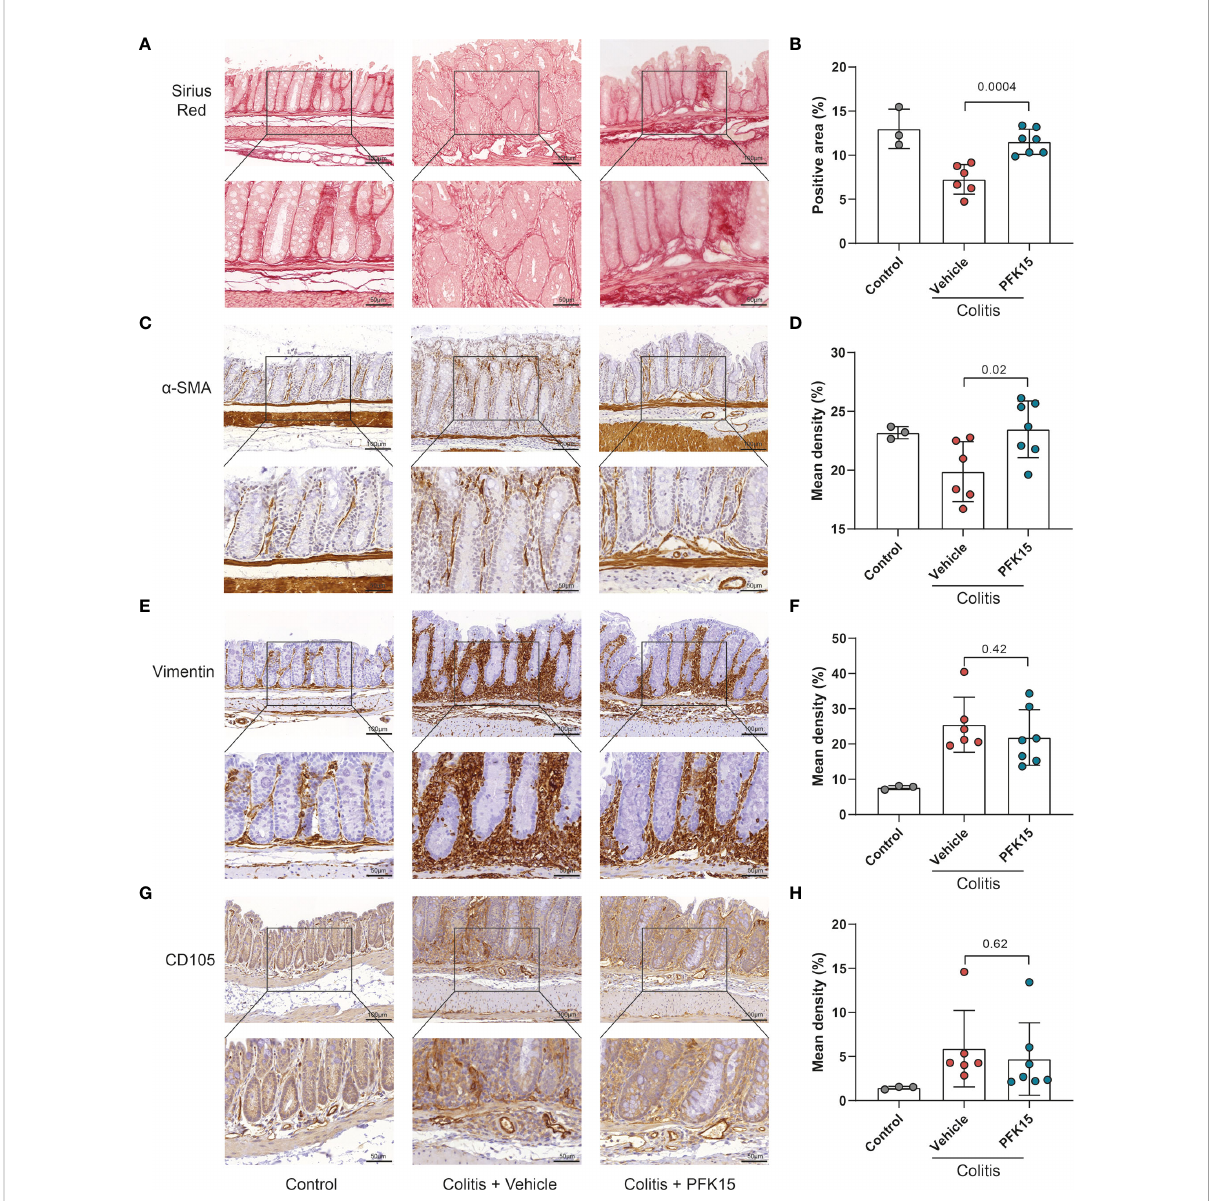
FIGURE 7 Inhibition of PFKFB3 restores the stromal in T cell transfer colitis. (A) Representative image from Sirius red staining of the colon. (B) Quanti fi cation analysis, based on the percentage of the positively stained area. Representative immunohistochemical staining of a -SMA (C) , vimentin (E) , and CD105 (G) with quanti fi cation analysis, based on the percentage of the positively stained area in the total area (D, F, H). Unpaired two-tailed t-test was performed to assess statistical signi fi cance between vehicle treated and PFK15 treated mice. Scale bar, 100 m m (upper panel) or 50 m m (lower